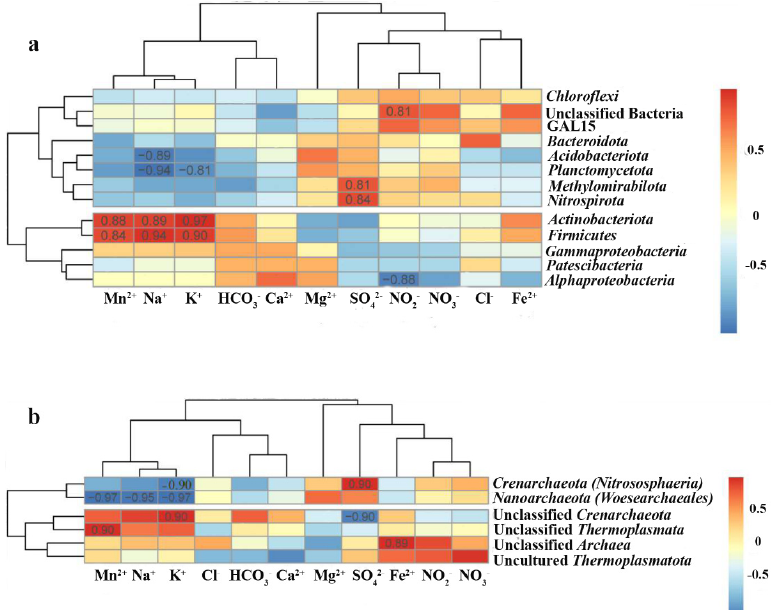
Figure 10. Heat map of correlation relationships (Spearman correlation) between ( a ) bacterial/( b ) archaeal taxa and the concentration of individual ions in the pore water of the investigated bottom sediments. Different colors indicate correlation coefficients based on the color scale to the right of the heat map. The coefficients p v < 0.05 are shown.